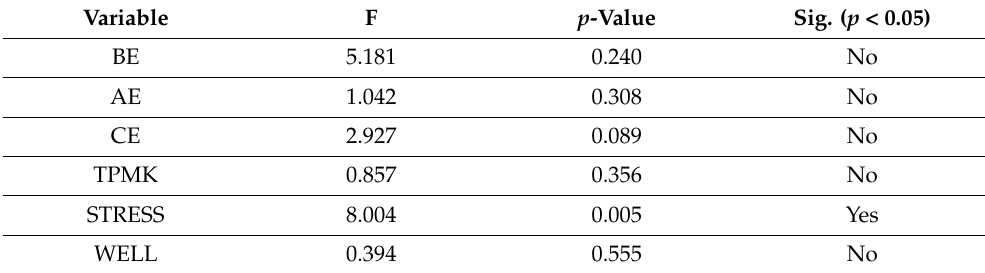
Table 8. Analysis of age differences on the engagement level, stress, well-being, and TPMK. Variable F p -Value Sig. ( p < 0.05) BE 0.325 0.808 No AE 0.402 0.752 No CE 0.187 0.756 No TPMK 0.118 0.877 No STRESS 1.850 0.022 Yes WELL 0.133 0.849